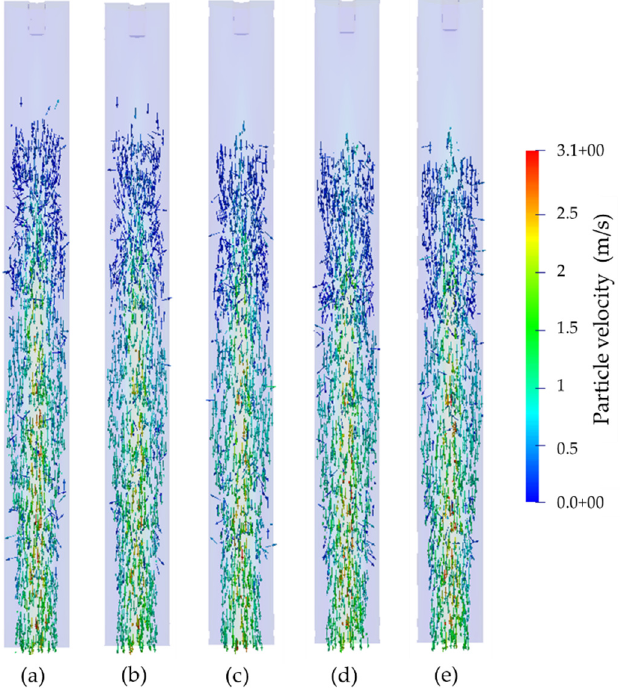
Figure 7. Numerical particle velocity vector distributions under different operating conditions: ( a ) U G = 0.11 m/s; ( b ) U G = 0.15 m/s; ( c ) U G = 0.18 m/s; ( d ) U G = 0.23 m/s; ( e ) U G = 0.27 m/s.